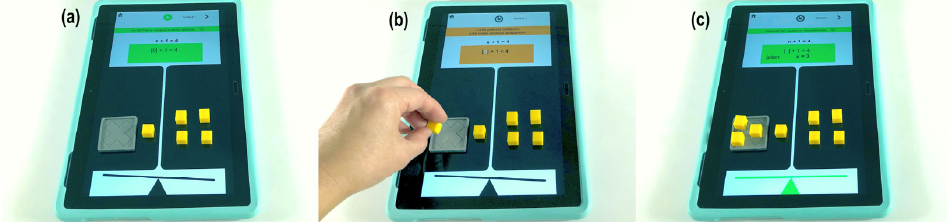
Figure 1. How to complete the level 1 exercise x + 1 = 4. ( a ) Equation modelling. ( b ) Equation solving by substituting values for the unknown. ( c ) The digital scale is balanced when the equation is solved (from [16] (p. 10) CC BY-NC).